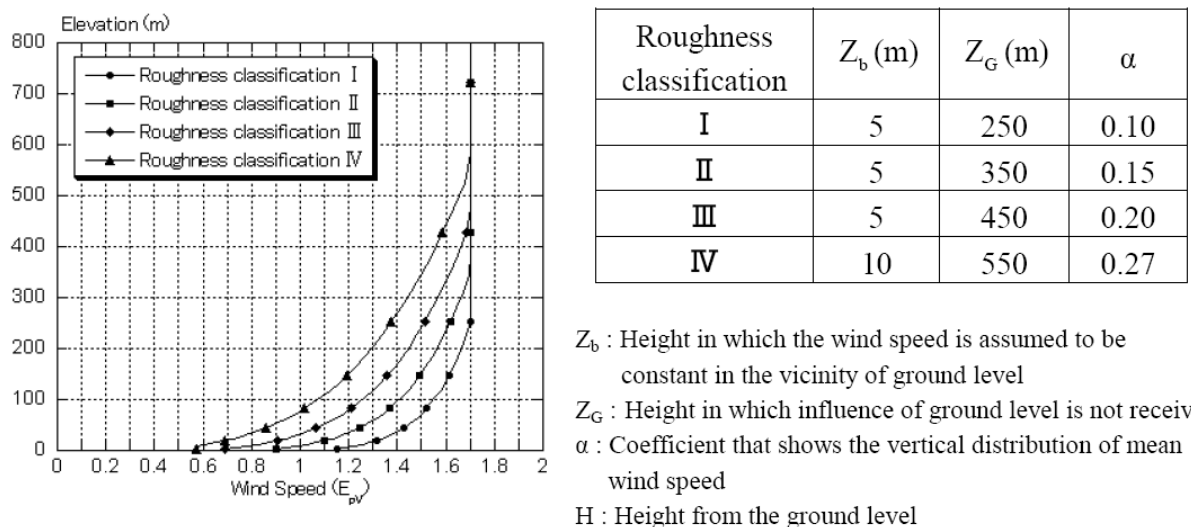
Figure 1. Height correction coefficient for the mean horizontal wind speed, E in Bulletin No. 1454 of the Ministry of Construction,